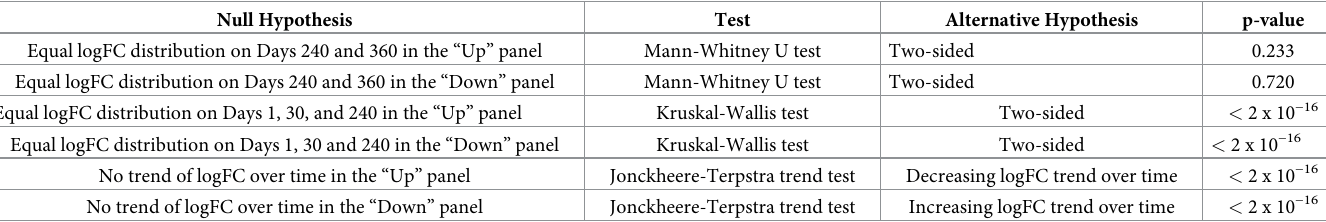
Heatmaps for 212 DEG reflecting potential short-term effects over time Heatmaps were generated for the 212 genes which were either in wound-related pathways with a p-value < 0.05 at Day 1, or having a p-value < 0.1 and changing in the same direction Table 1. Test results for means and trends of trajectories of the 212 genes associated with short-term effects from the repeated acute ISO exposures. Null Hypothesis